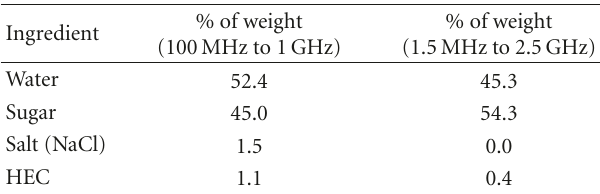
Table 2: Body tissue recipes